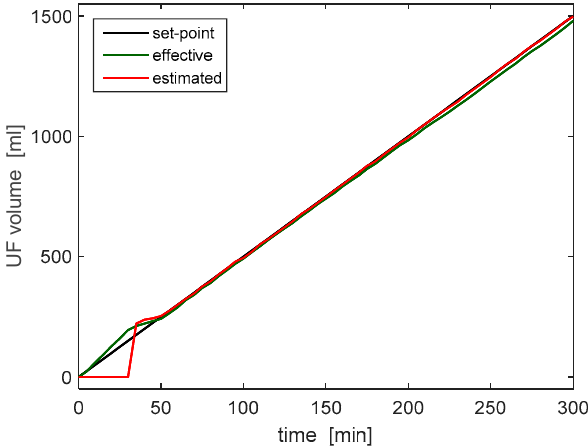
Figure 12. Ultrafiltrate volumes set in the device (black), estimated by RAP (red) and effectively measured by external scale (green).